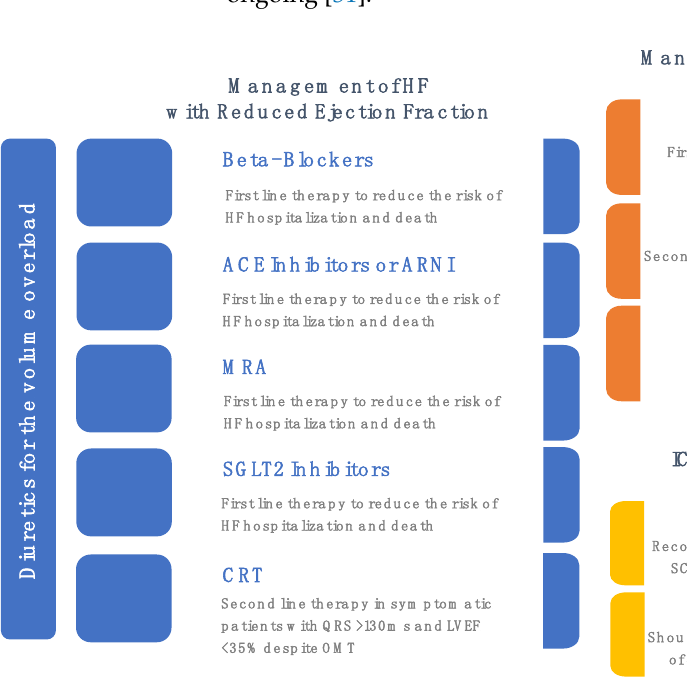
Figure 3. Medical treatment of PLN R14del cardiomyopathy manifestations. ACE, angiotensin converting enzyme; ARNI, angiotensin receptor neprilysin inhibitor; CRT, cardiac resynchronization therapy; HF, heart failure; ICD, implantable cardioverter defibrillator; LVEF, left ventricular ejection fraction; MRA, mineralocorticoid receptor antagonist; OMT, optimal medical treatment; SCA, sudden cardiac arrest; SGLT2. sodium-glucose co-transporter-2; VA, ventricular arrhythmia; VT, ventricular tachycardia.